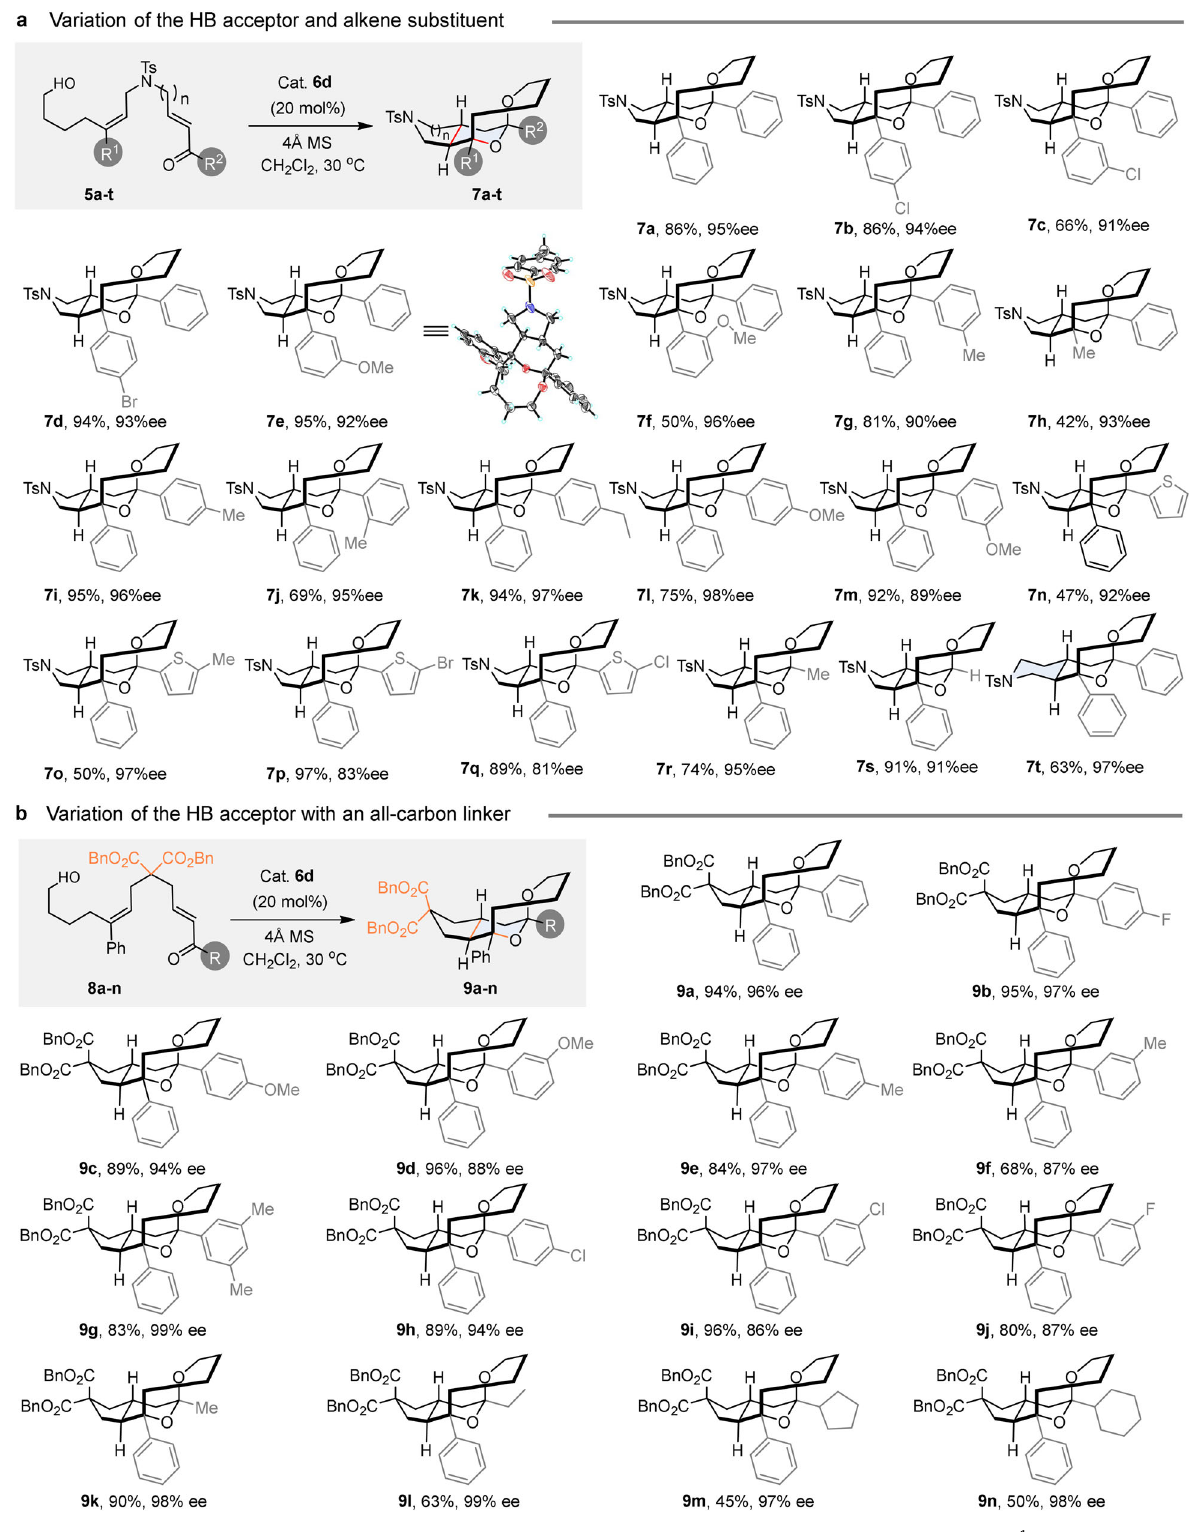
Fig. 3 Scope of the reaction with α , β -unsaturated ketones as the HB acceptor. a Variation of substituent on both the alkene (R 1 ) and the α , β -unsaturated ketone (R 2 ) for substrates with an tosylamide linker. b Variation of substituent R on the α , β -unsaturated ketone for substrates possessing an all carbon- linker. Reactions were performed with 30 mg of susbtrate 5a – t or 8a – n and 4 Å MS (60 mg) in the presence of catalyst 6d (20 mol%) at 30 °C in 1.0 mL DCM for 48 – 60 h. Isolated yields are given; only a single stereoisomer was isolated (d.r. > 20:1); ee were measured by chiral HPLC